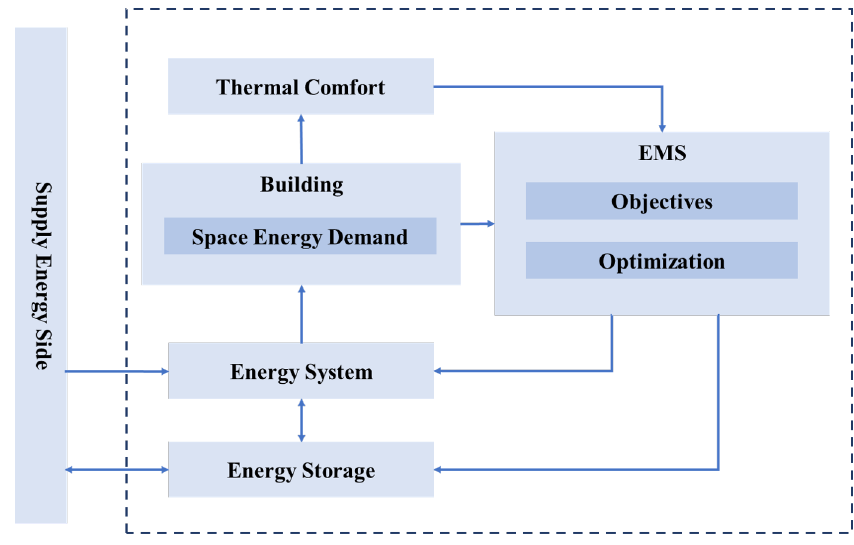
Figure 7. Schematic concept of an integrated EMS